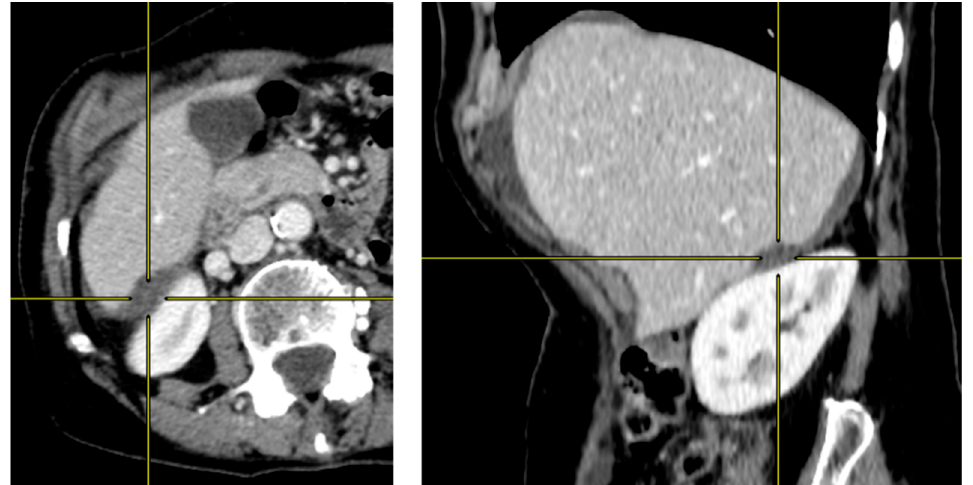
Figure 2. Multiplanar reconstruction for assessing equivocal liver scalloping on axial image. Axial contrast-enhanced CT image ( left ) showing an equivocal liver scalloping of intraperitoneal mucin deposition in the Morison pouch. Sagittal reconstruction CT image ( right ) showing a clearer indentation of the liver, allowing a confident assessment of liver scalloping.